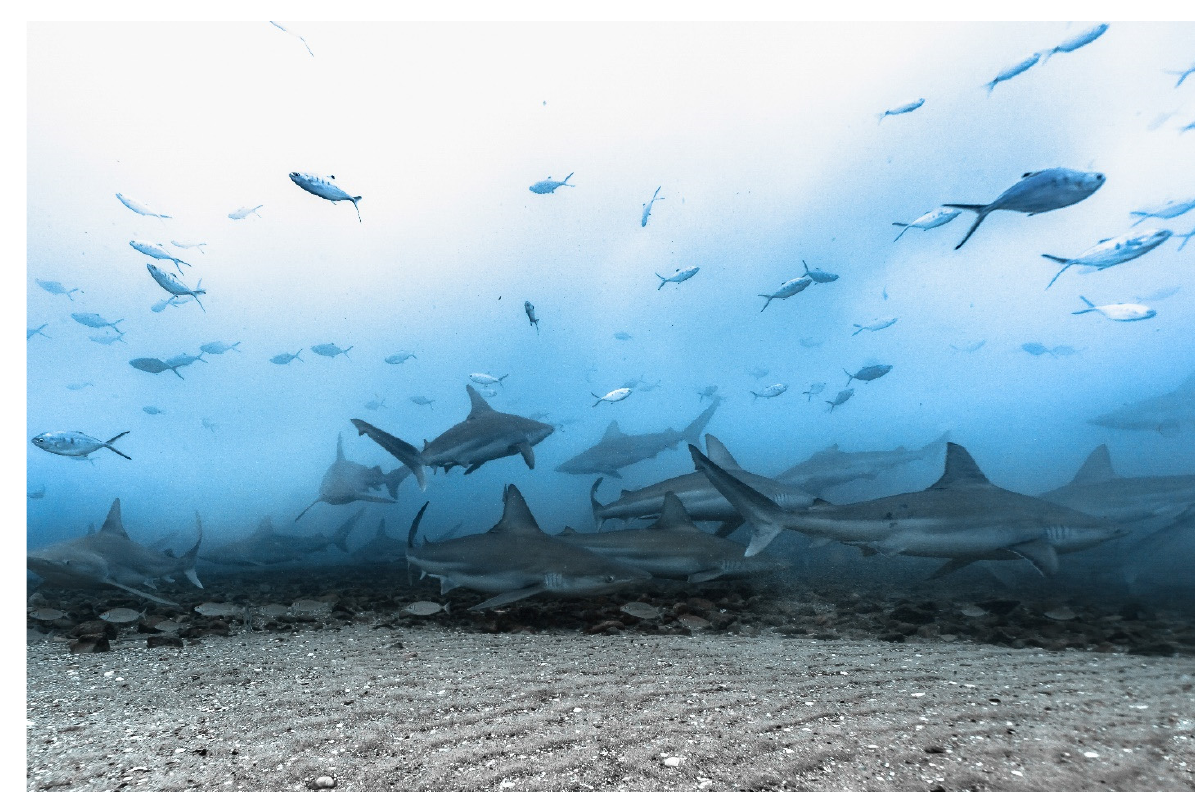
Figure 3. Carcharhinus plumbeus swimming under the current at 7 m. (The photo was reprinted with permission from Ilan Elgrably).